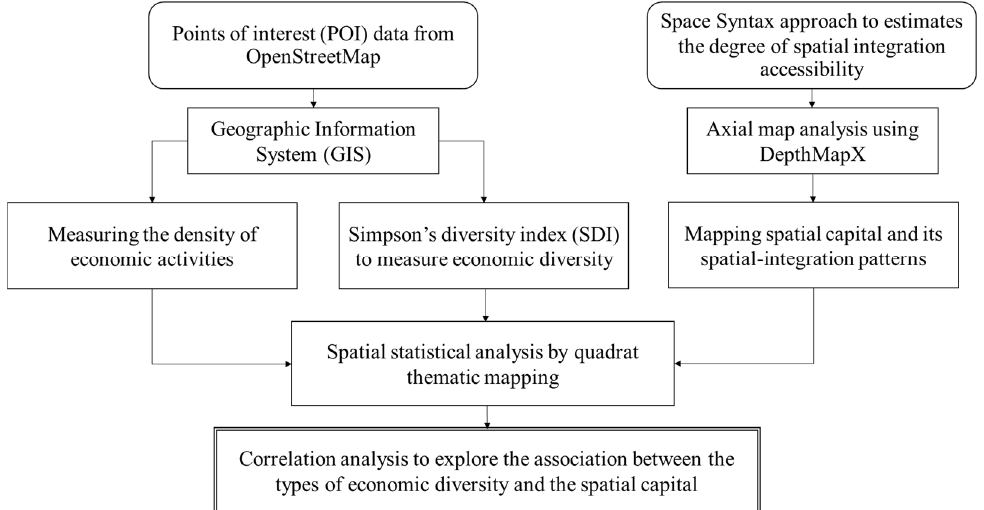
Figure 3. The analytical framework in this study